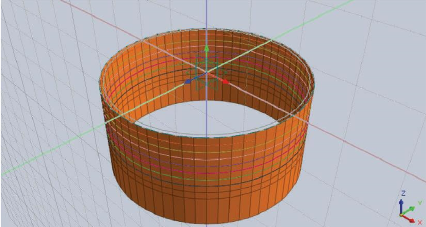
Figure 6: Grid diagram of the support structure (diaphragm wall and